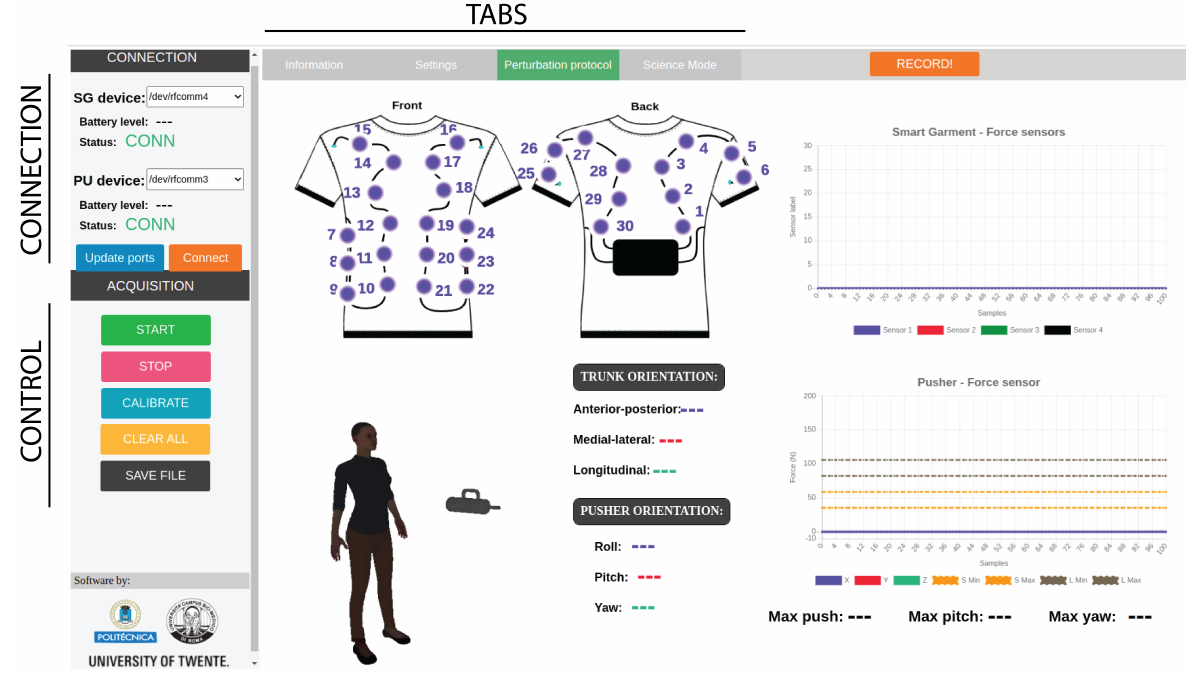
Figure 4. User interface to control balance assessment with BenchBalance